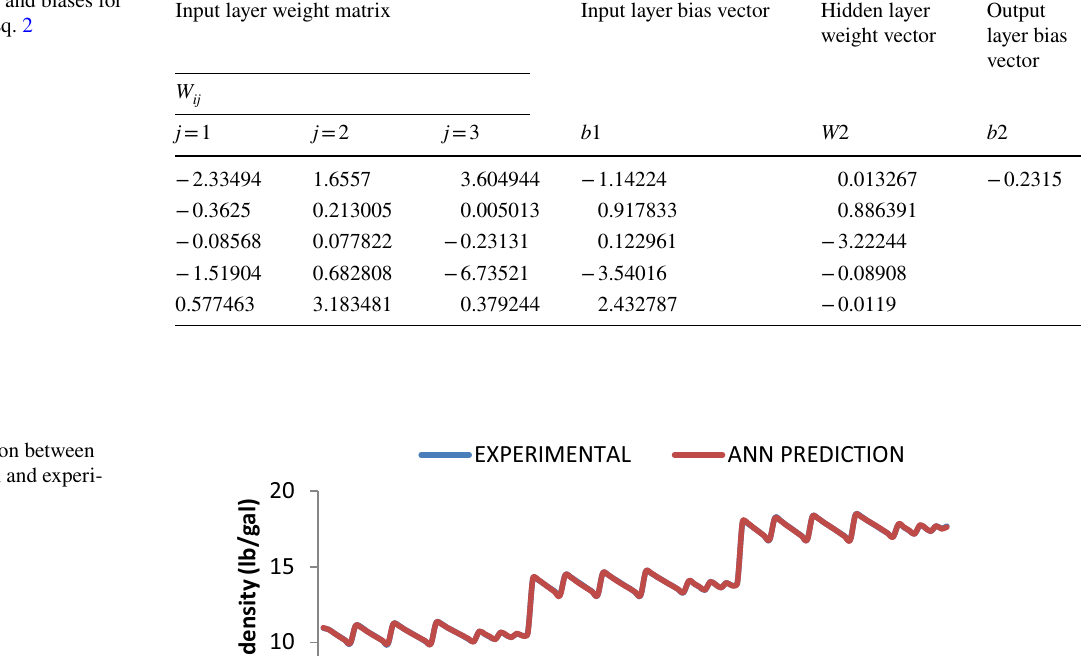
Table 6 Weights and biases for ANN model in Eq. 2